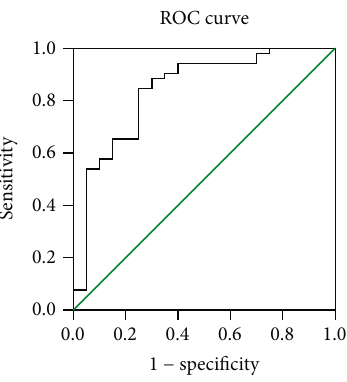
Figure 2: ROC curve of the ratio of CD56 bright NK to CD56 dim NK. The curve plots the relationship between sensitivity and 1 − speci fi city for di ff erent cut-o ff levels. When 0.0487 was used as the cut-o ff point for the diagnostic score of suspected pSS patients, the maximum value of the Youden index was achieved as